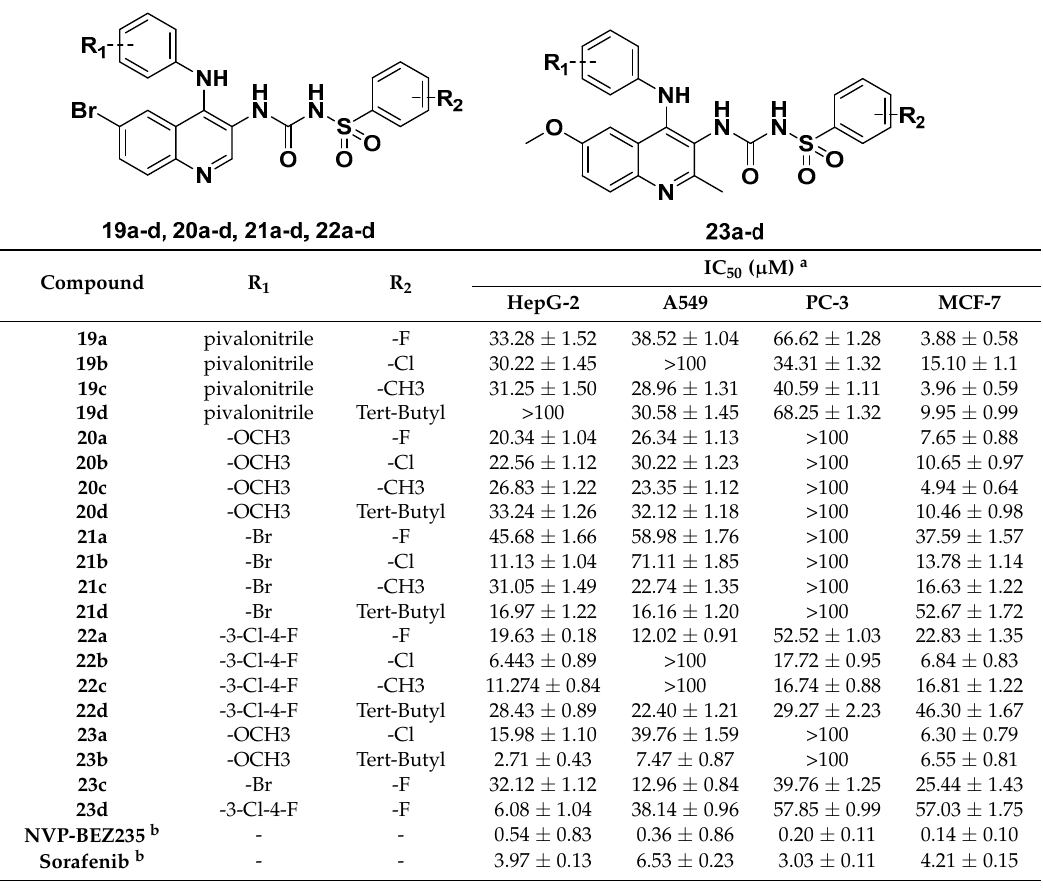
Molecules 2018 , x , x FOR PEER REVIEW